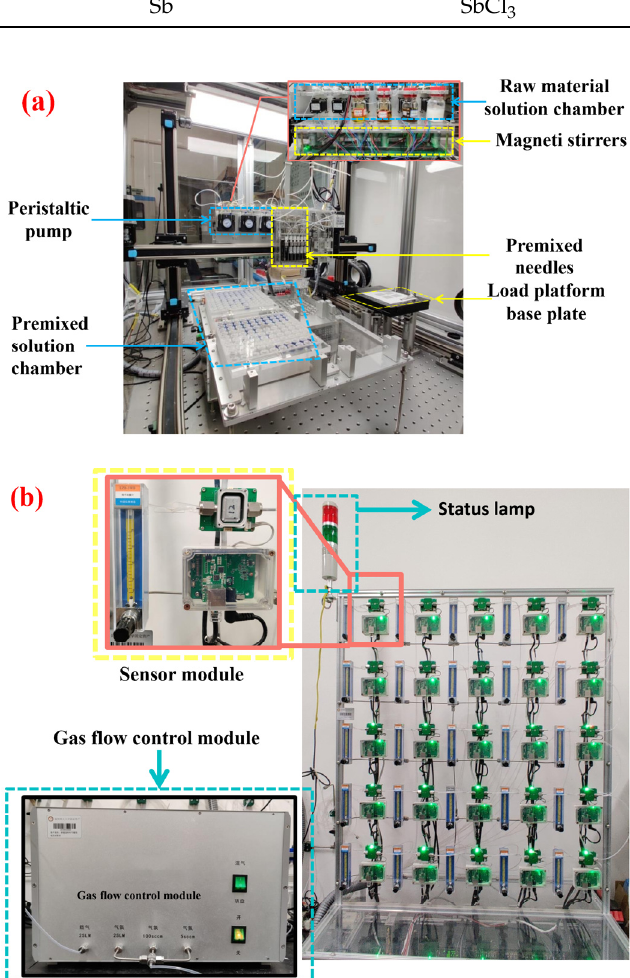
Figure 1. Physical picture of equipment. ( a ) Parallel gas-sensitive film synthesizer; ( b ) high-throughput gas-sensitive performance tester. Table 1. Modifies the type of element and its added proportions.